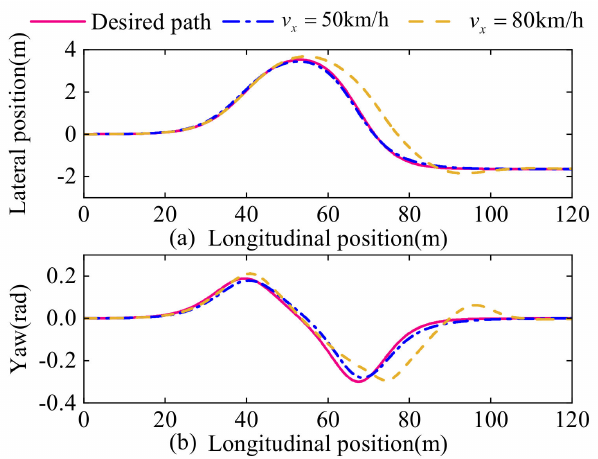
Figure 10. Response of the lateral position and yaw under different longitudinal speeds: ( a ) lateral position; ( b )